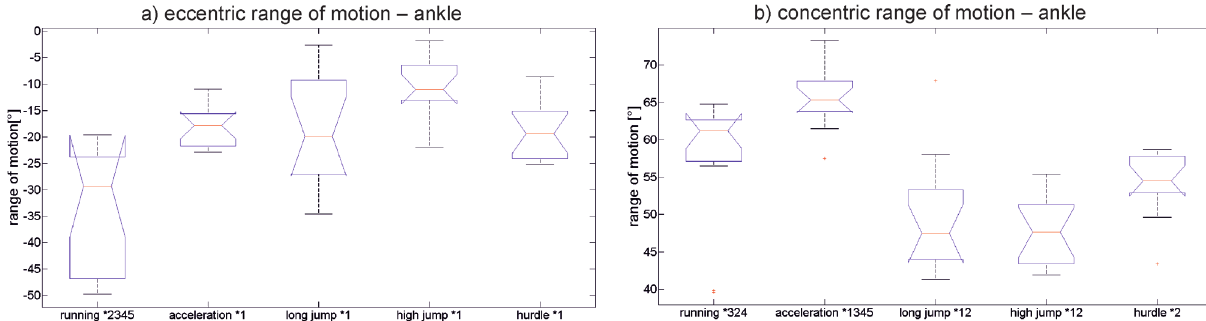
Figure 3. Eccentric (a) and concentric (b) range of motion in the ankle joint. Box graphs display the distribution of values of each type of the jump. Significant differences ( p < .05) are denoted with * and numbered with relation to the take-off type: 1 – running, 2 – acceleration running, 3 – long jump, 4 – high jump, 5 –